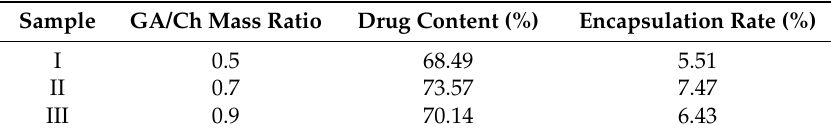
Figure 3. The size distribution of PPM. Table 1. The drug content and encapsulation efficiency of PPM. Table 1. The drug content and encapsulation efficiency of PPM.